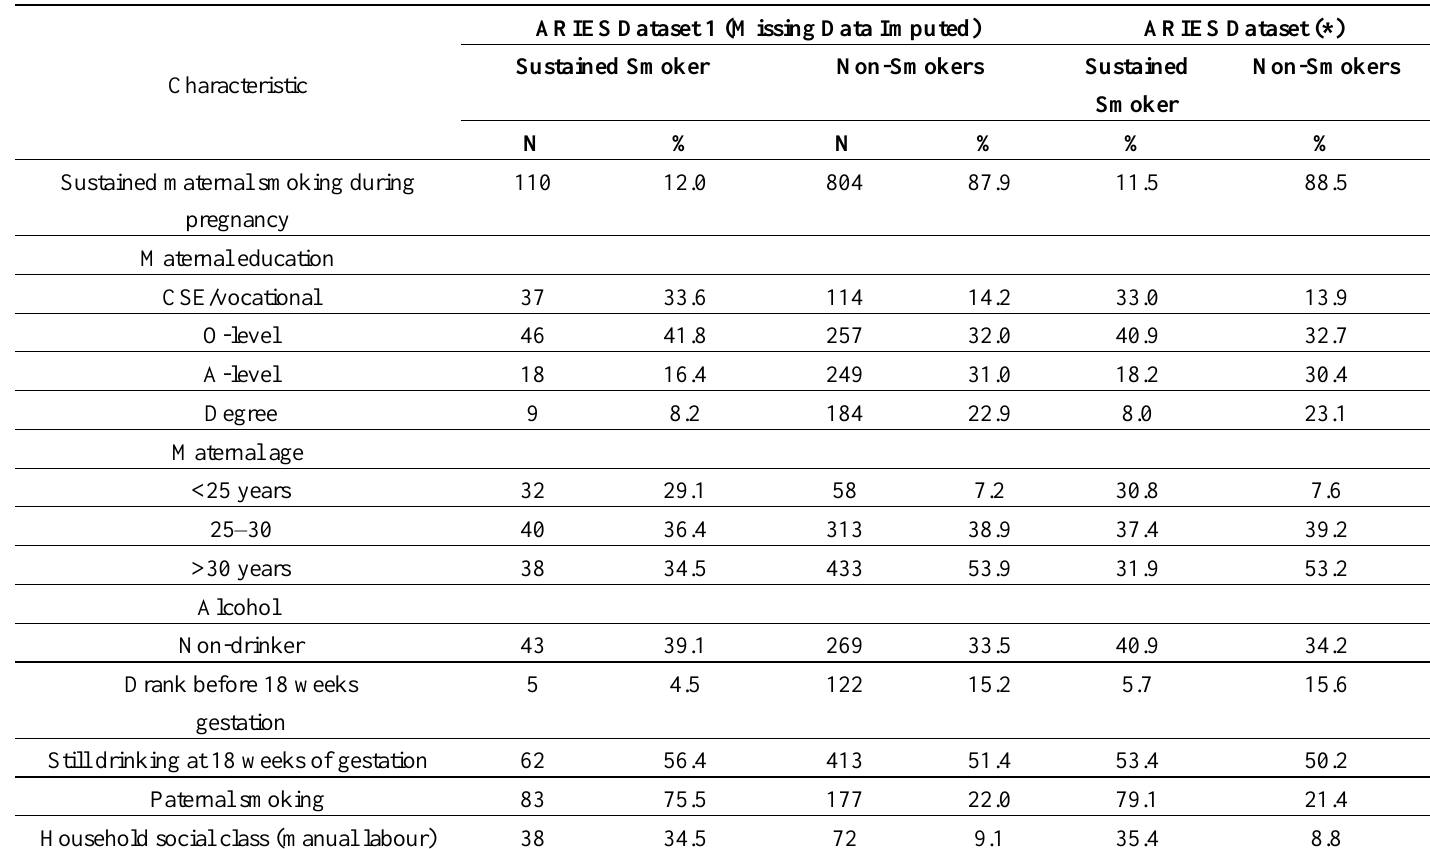
Table 1. Demographic characteristics of imputed ARIES dataset